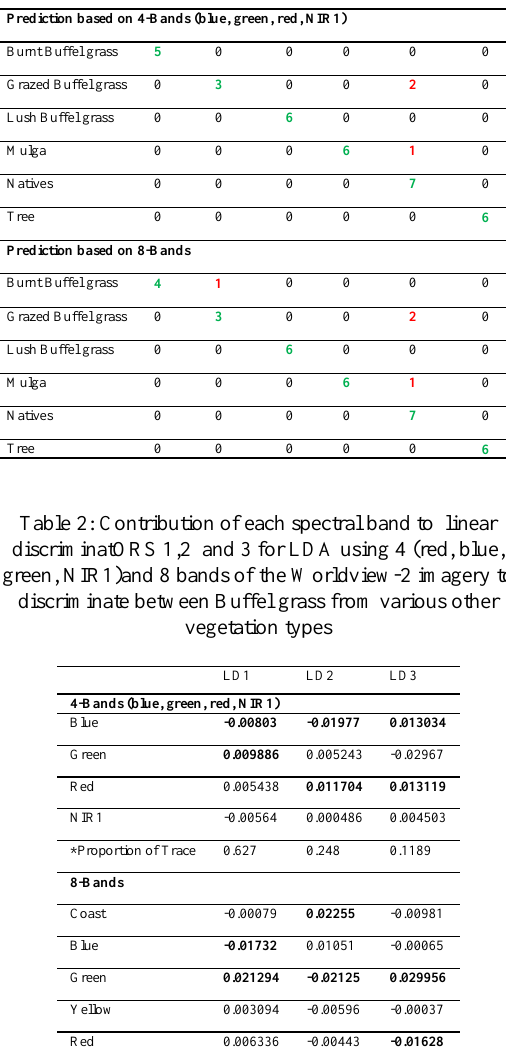
Table 1: Predictions made based on the LDA using 4 (red, blue, green, NIR1) and 8 bands of the Worldview-2 imagery to discriminate between Buffel grass from various other vegetation types. Correct classifications are presented in green, misclassifications are presented in red. Grazed Tree Prediction based on 4-Bands (blue, green, red, NIR1)